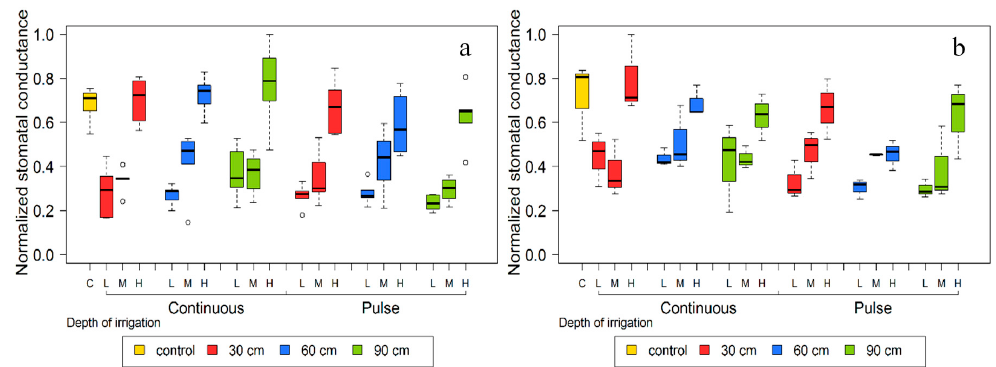
Figure 4. Normalized stomatal conductance data obtained at ( a ) 80 and ( b ) 44 DBH. In the boxplot, the upper and lower whiskers represent the maximum and minimum values, the upper and lower box borders represent the 75th and 25th percentile values, respectively, and the horizontal dark line indicates the median. C = control, 100% standard irrigation rate; L = low level of irrigation, 15%; M = medium level of irrigation, 30%; H = high level of irrigation, 60%.